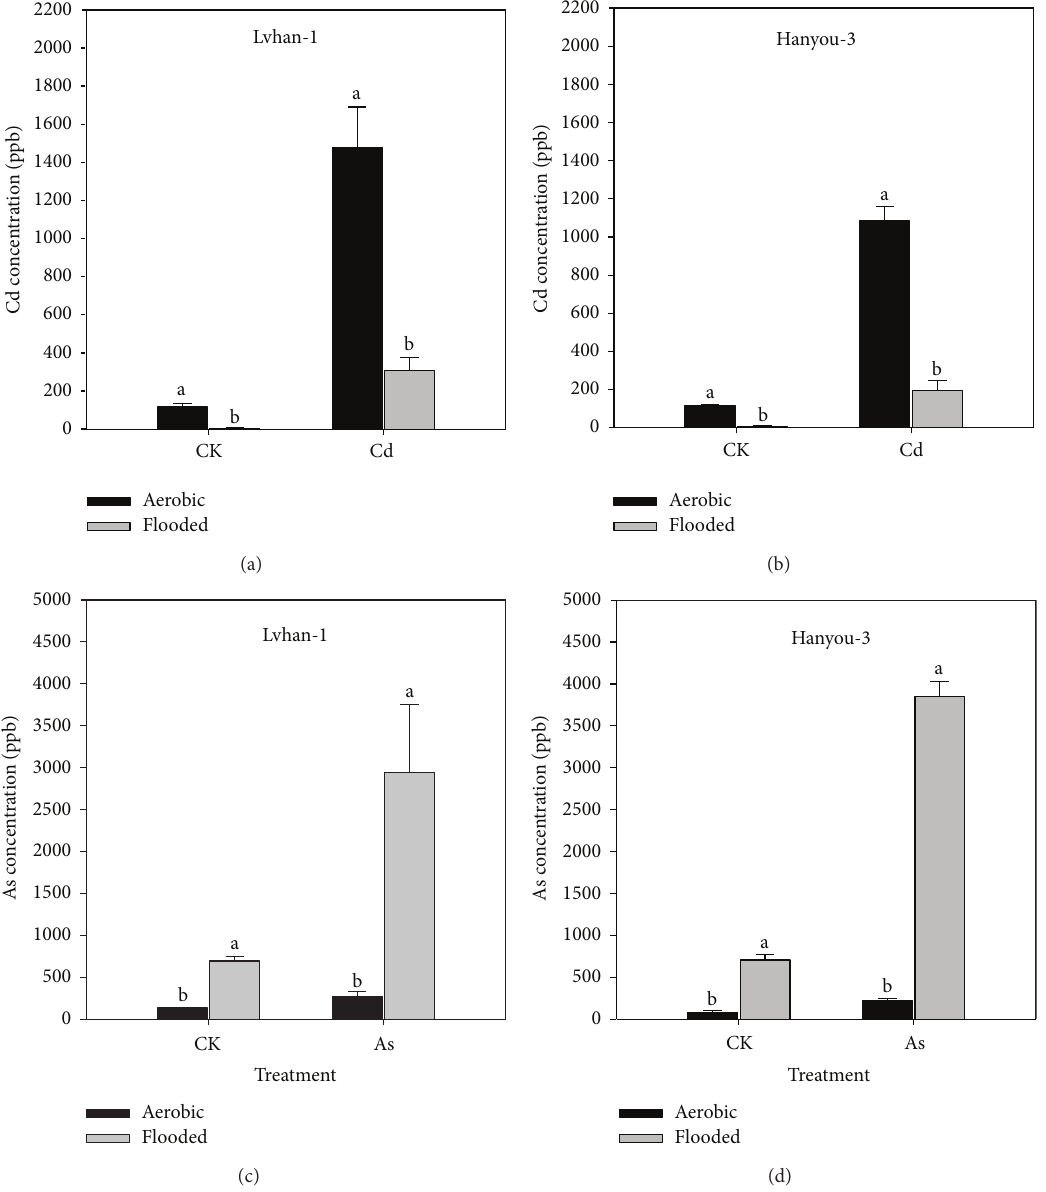
Figure 1: The Cd and As concentration in grains of Lvhan-1 and Hanyou-3 grown in the soil with additions of Cd, As, and without Cd or As addition (ck) under aerobic and flooded cultivation in a pot experiment. The rates of Cd and As were applied at 2.5 mg Cdkg −1 of soil as cadmium chloride and 5.0 mg As kg −1 of soil as cacodylic acid sodium salt, respectively. Error bars represent standard error of mean